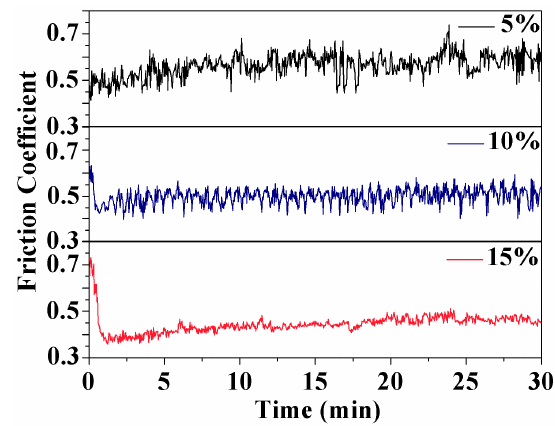
Figure 7. Friction coefficient of the NiCr–TiB 2 –ZrB 2 coatings.